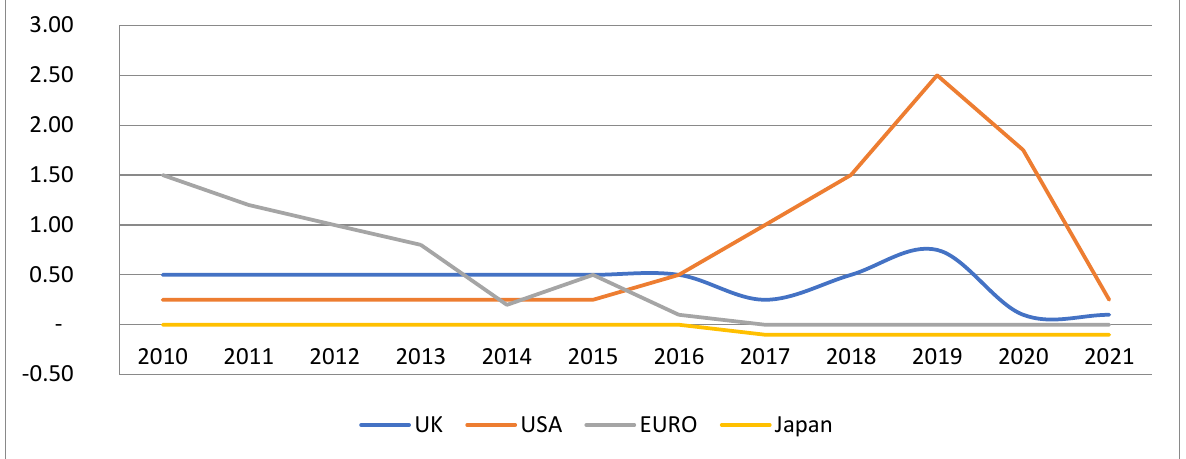
Figure 5. The level of the base rate (%) in the years 2010 – 2021. Source [78 – 85].